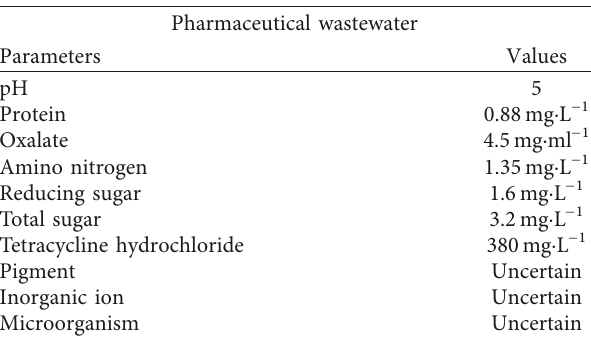
Table 1: Main components of